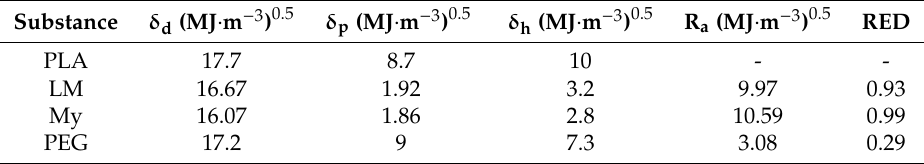
Table 1. Calculated Hansen Solubility Parameters of polylactide (PLA), limonene (LM), myrcene (My), and poly(ethylene) glycol (PEG) by means of the software